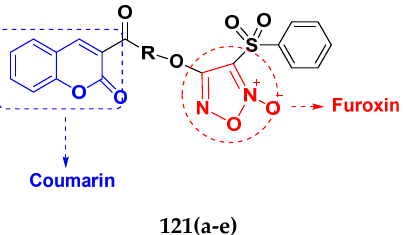
Figure 115. Structure of coumarin-based furoxin derivatives 121 ( a – e ). Table 102. In vitro cytotoxic activities of coumarin-based furoxin hybrid compounds 121 ( a – e ). Compound No.